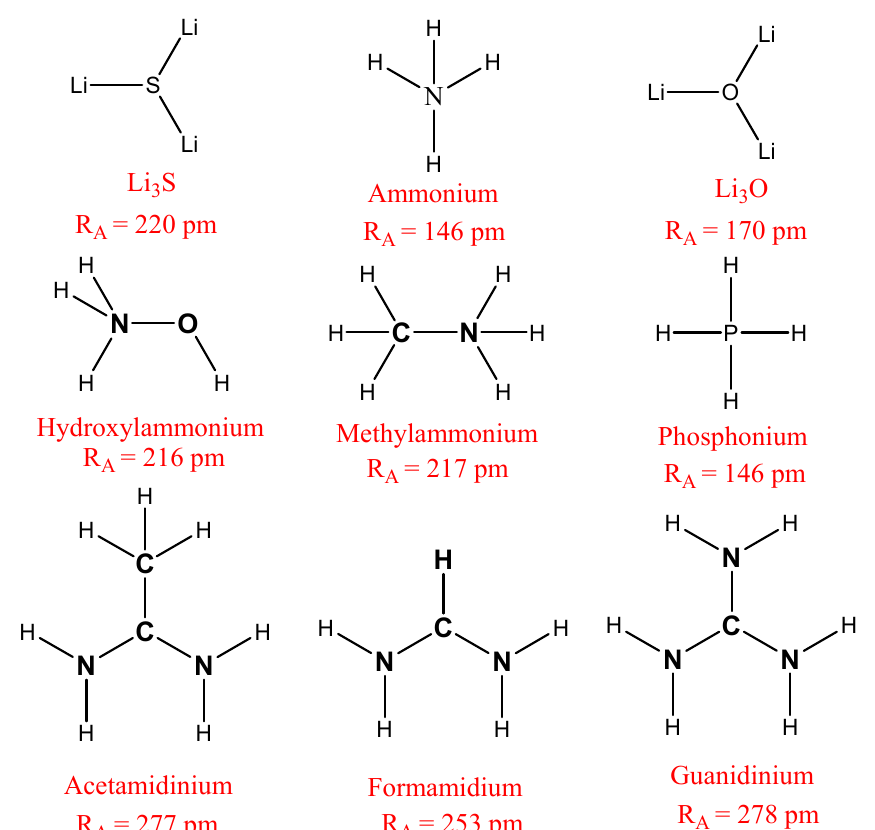
Figure 2. The chemical formula for the cations studied in this paper. For all substitutions (except for Li 3 O and Li 3 S), the short circuit current ( J SC ), the open-circuit voltage ( V OC ) and the power conversion efficiency (PCE) are also calculated. We hypothesized that every photon energy above E is absorbed, always promoting the perovskite to generate electron-hole pairs